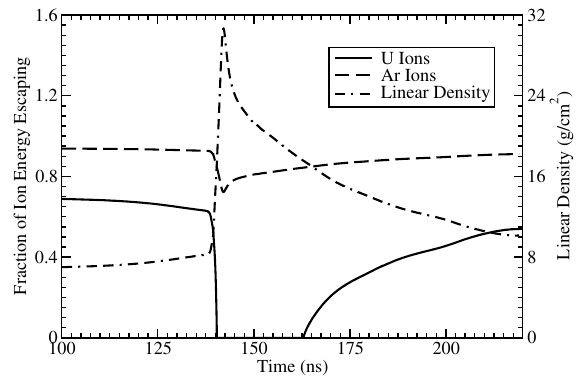
FIG. 27. Same as in Fig. 26, but using the beam-target geometry shown in Fig. 4(b).